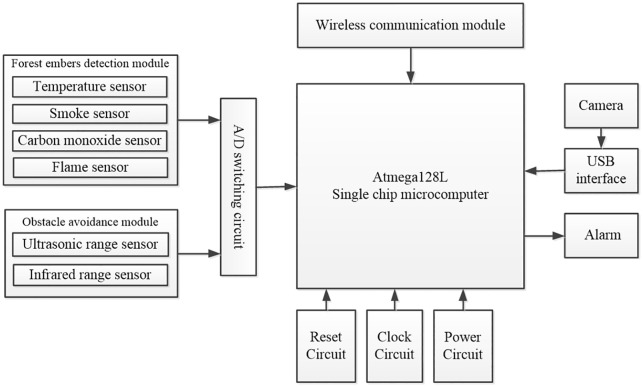
System overall design.